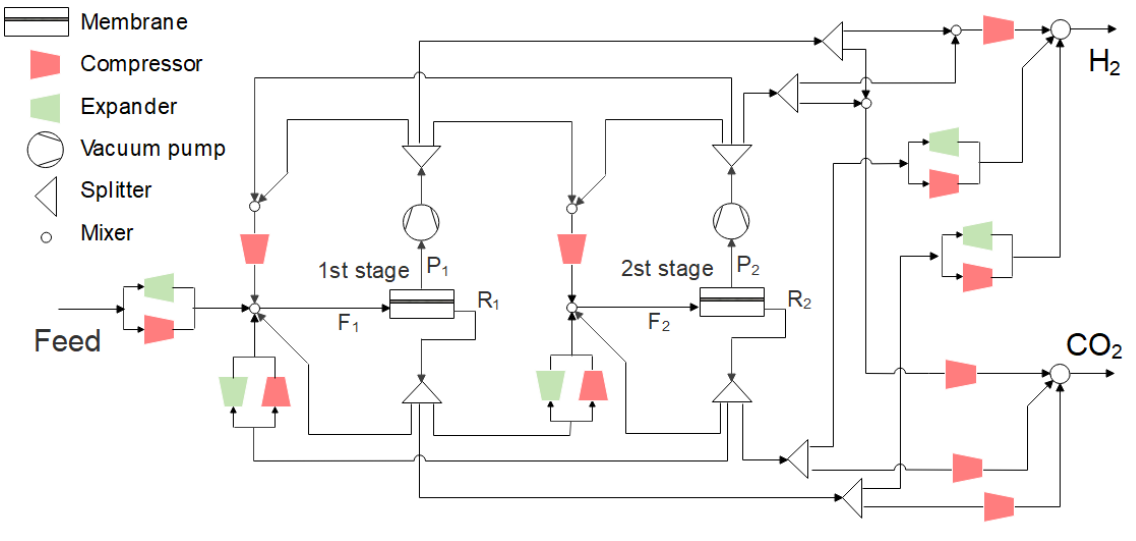
Figure 2. Superstructure model of two ‐ stage membrane process.